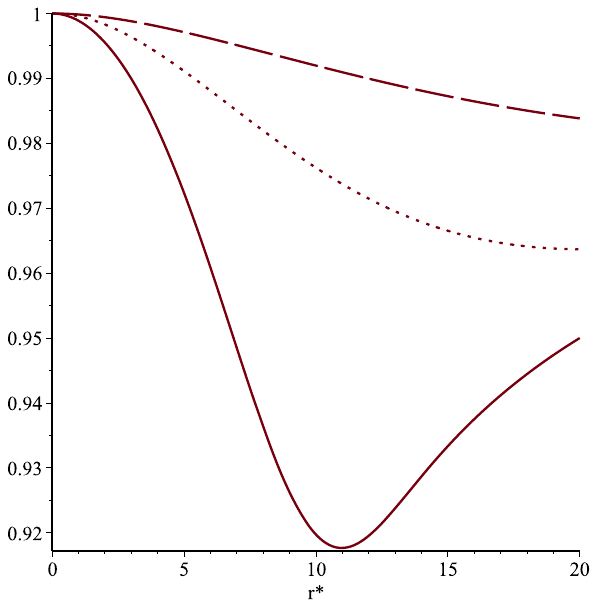
Fig. 8 Plot of the metric coefficient g00 given by (33) in the case H = 10 and μ = 0.05 for ξ = 0.2 (solid line), ξ = 0.7 (dotted line) and ξ = 1.0 (longdashed line)